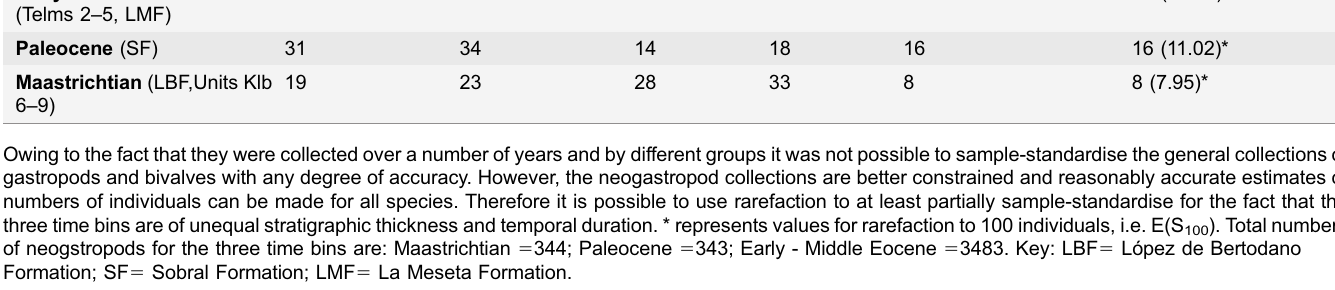
Table 1. Numbers of gastropods and bivalves in the three stratigraphic intervals investigated.